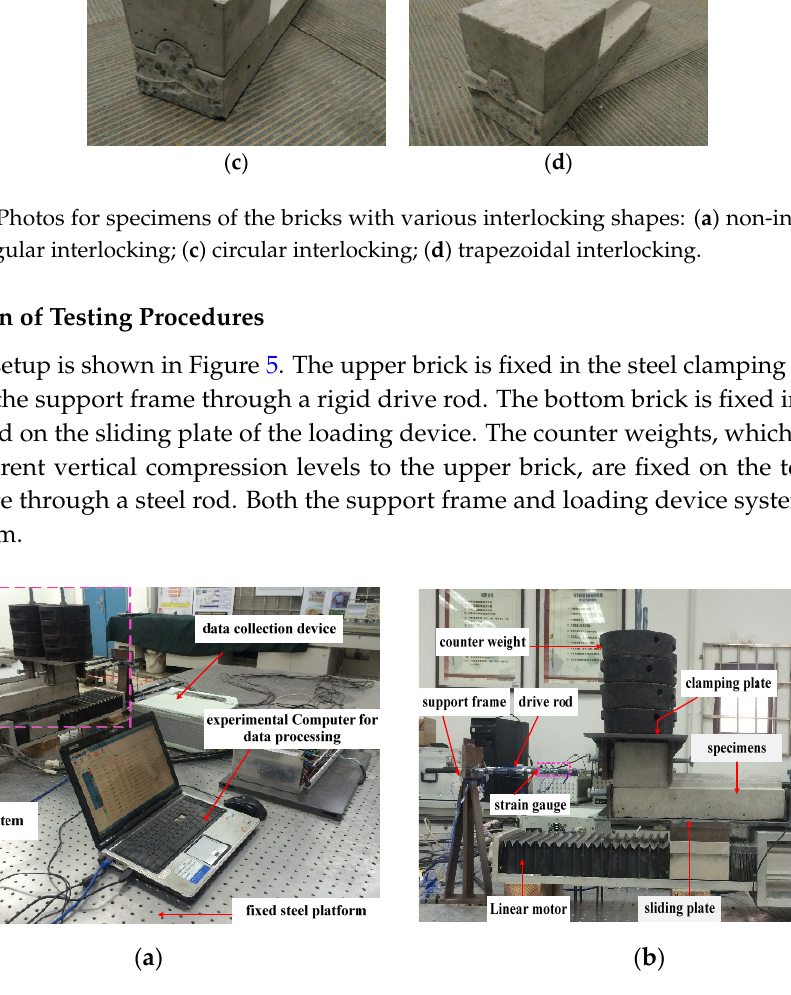
Figure 5. Test setup: ( a ) entire view; ( b ) loading system.